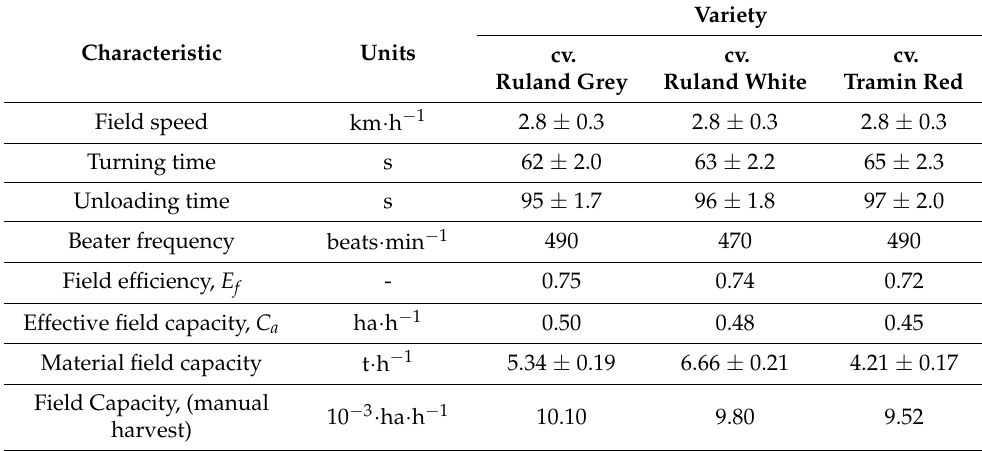
Table 5. Operating characteristics of grape harvesters (mean ±